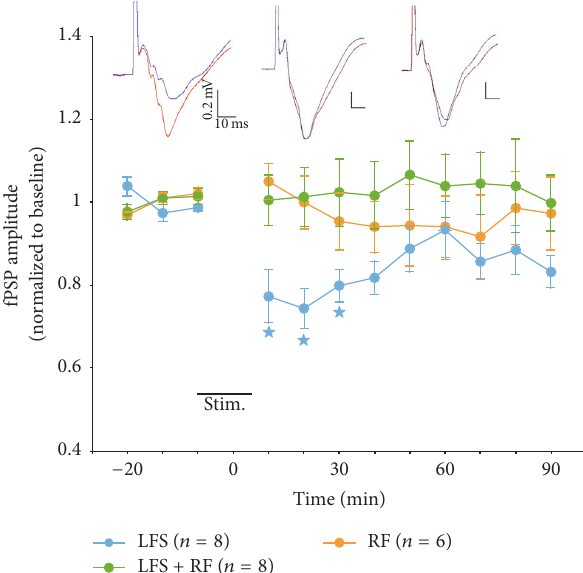
Figure 1: Amplitude of fPSPs recorded in V1 in response to single pulse stimulation of the LGN in urethane-anesthetized rats. Appli- cation of LFS (stim.) to the LGN resulted in significant depression of fPSP amplitude. The effect of LFS to elicit LTD was blocked in rats that received paired LFS + RF stimulation. Stimulation of the RF alone did not result in any significant changes in fPSP amplitude. The inserts depict fPSPs recorded before (red) and after (blue) application of the respective stimulation protocol (left: LFS; middle: LFS + RF; right: RF). Asterix ( ∗ ) indicates significant ( 𝑃 < 0.05 ) difference between LFS and LFS + RF